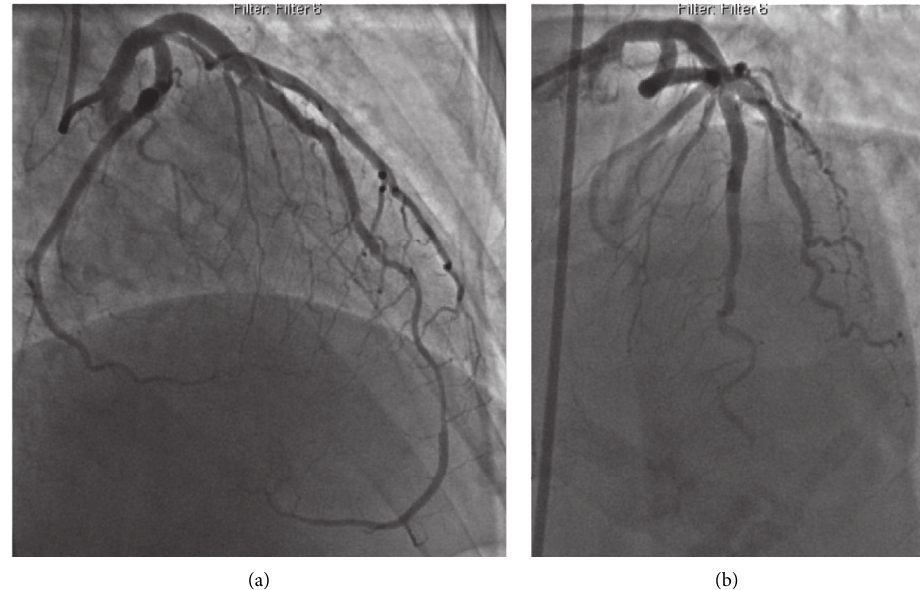
Figure 3: (a) Type 2A SCAD of the mid to distal LAD. (b) Unsuccessful PCI with occluded distal LAD and final TIMI 0